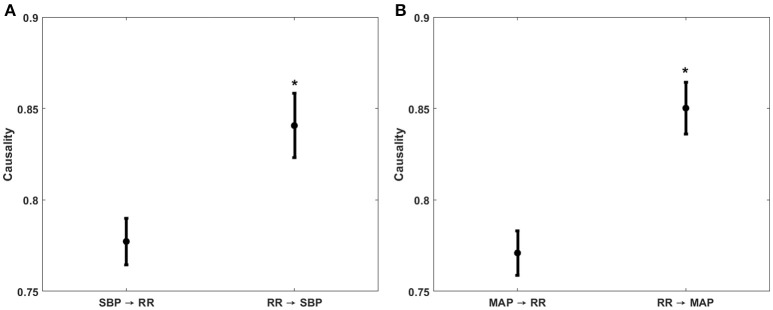
Comparison of non-baroreflex or feedforward (RR→SBP and RR→MAP) and baroreflex or feedback (SBP→RR and MAP→RR) causalities during supine baseline. The feedforward causality was significantly stronger (p < 0.001) than the feedback causality for both RR↔SBP (A) and RR↔MAP (B) interactions. *Represents significantly (p < 0.05, one-way ANOVA) stronger causality.